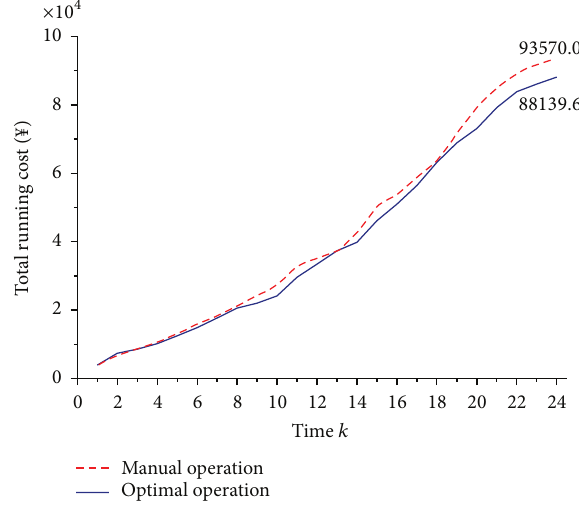
Figure 7: The comparison of